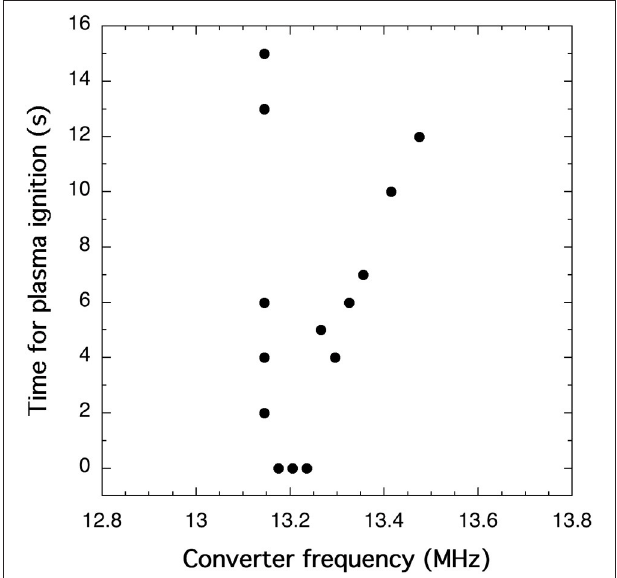
FIGURE 5 | Time for the plasma to ignite vs. operating frequency for the IRUKANDJI atmospheric pressure test configuration of Figure 1 ; gas flow rate is 20 sccm and pulsed operation is at 20 kcycles yielding a constant gate current of 0.05 A. Due to the non-linearity of the Converter the power decreases from P MiniPR = 2.88 W at 13.17 MHz to 1.6 W at 13.475